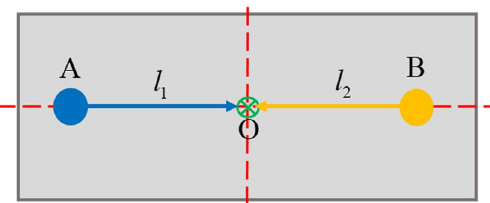
Figure 5. Positional relationship between actuators 1 and 2 (Top view of the